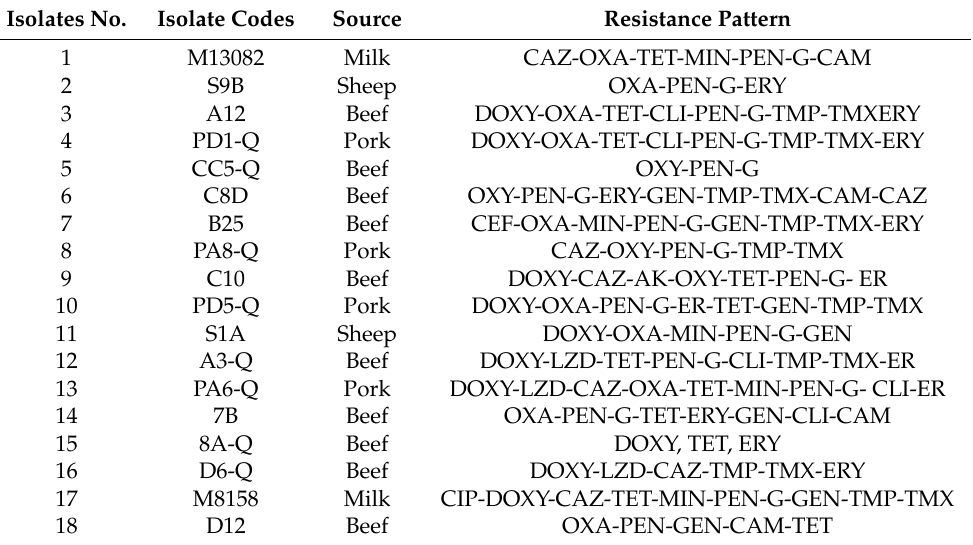
Table 3. Multidrug resistance profiles of Staphylococcus aureus isolates to the tested. Isolates